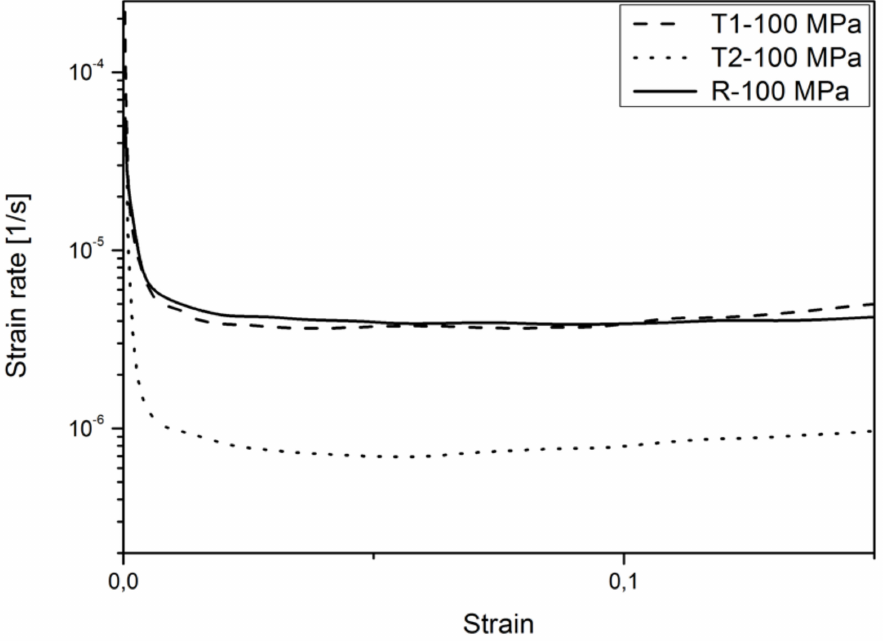
Figure 6. Strain rate vs. strain creep curves: comparison between the curves obtained under the same applied